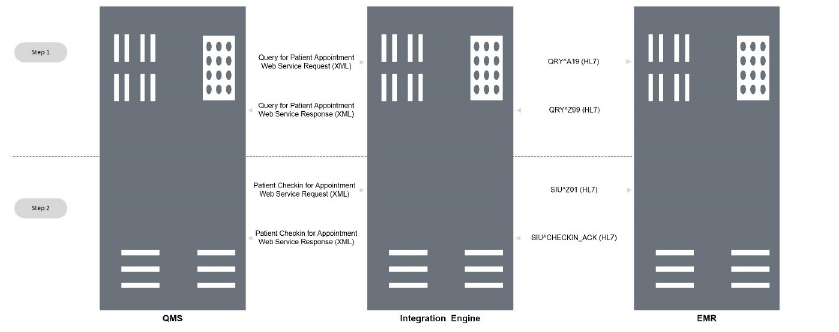
Fig 3. Data flow between integration components.